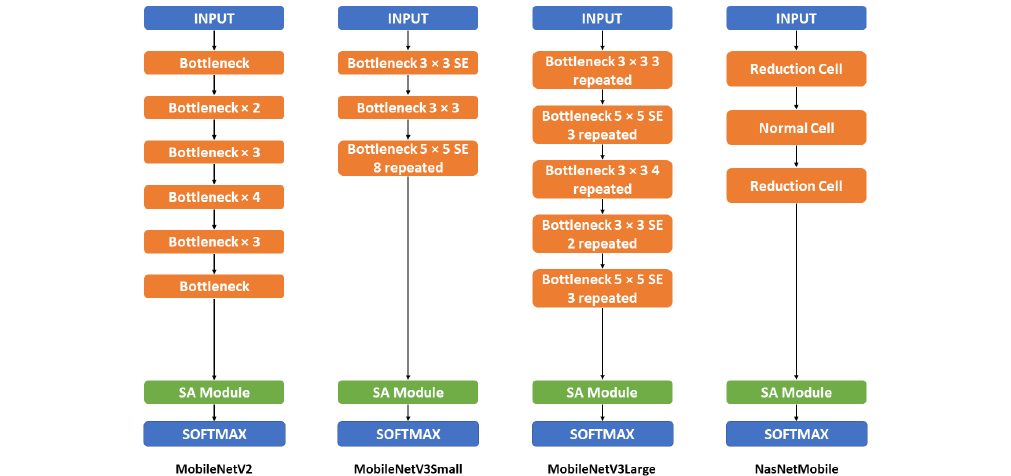
Figure 4. Mobile-based backbone model architecture. This figure shows the overall structure of the mobile-based backbone model including MobileNetV2, MobileNetV3Small, MobileNetV3Large, and NasNetMobile. The detailed structure and information can be found in the Table A2 in Appendix